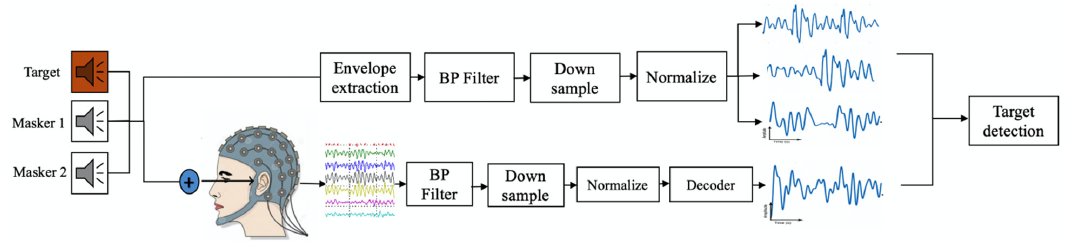
Figure 2. Procedure of the attended speech detection from EEG signal in three-speaker cocktail party test.